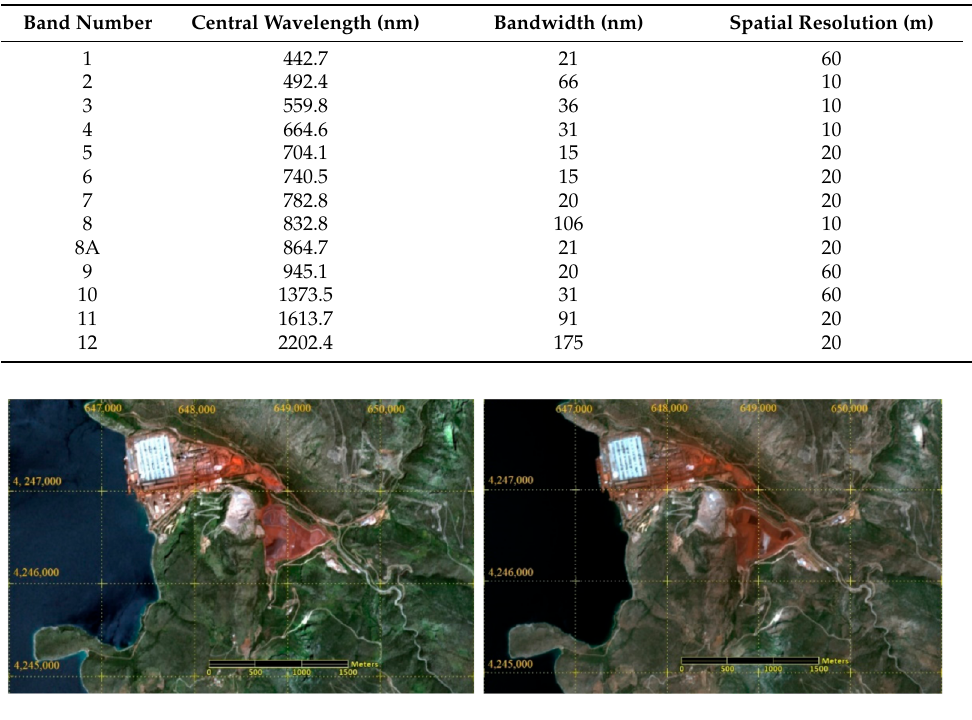
Figure 4. Sentinel-2-true color composite image (RGB = 4,3,2, date: 29 April 2019) representative of piled materials in March–April and Sentinel-2-Image (30 July 2019- Left ) representative of piled materials in June–July (29 April 2019- Right